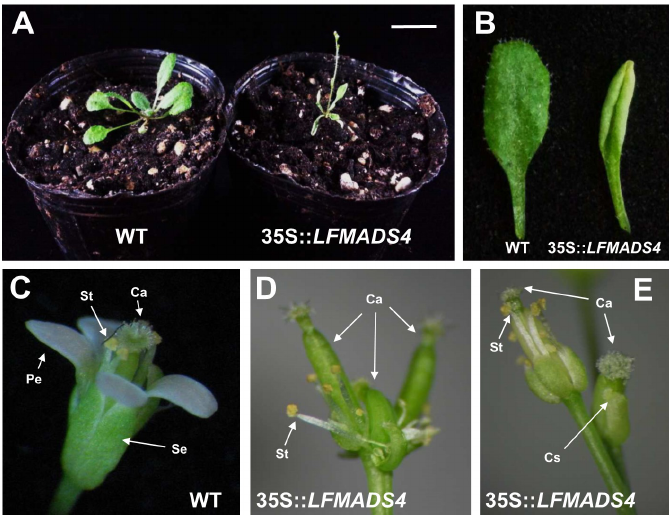
Figure 8. Overexpression of LFMADS4 promotes flowering and causes curly rosette leaf and floral homeotic transformation in Arabidopsis . ( A ) Early-flowering phenotype in 35S::LFMADS4 transgenic Arabidopsis (right) compared to wild-type (WT) (left) under long-day condition. Bar = 1 cm. ( B ) Phenotype of curly rosette leaf in 35S::LFMADS4 transgenic Arabidopsis (right) compared to WT (left) with normal rosette leaf. ( C ) Normal floral structure in WT. ( D , E ) Floral structure shows homeotic transformation in the first whorl (sepal) and second whorl (petal) in 35S::LFMADS4 transgenic Arabidopsis . The flower with complete conversion of the sepal into carpel or carpellnoid sepal in the first whorl, and the petal into stamen in the second whorl are represented in the main inflorescence ( D ) and lateral inflorescence ( E ), respectively. Se: sepal, Pe: petal, St: stamen, Ca: carpel, Cs: carpellnoid sepal.